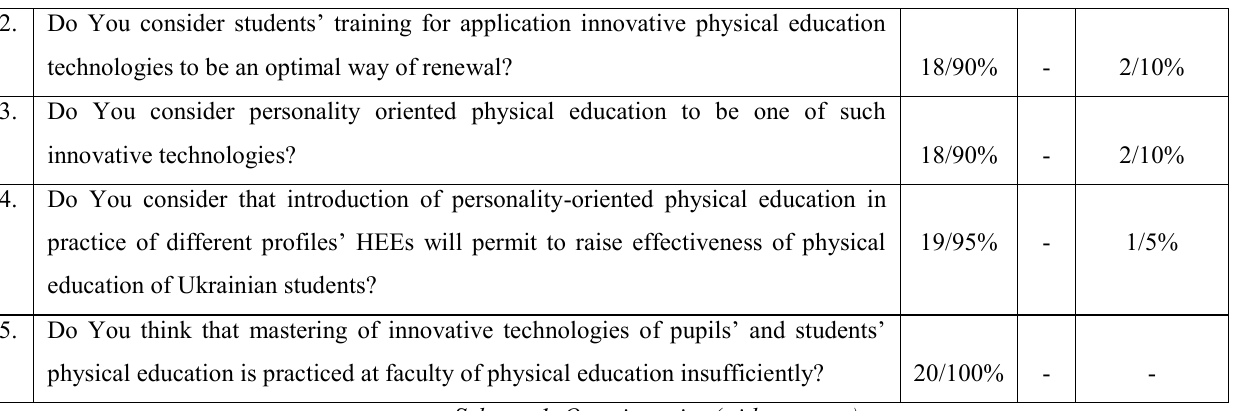
Schema 1. Questionnaire (with answers)